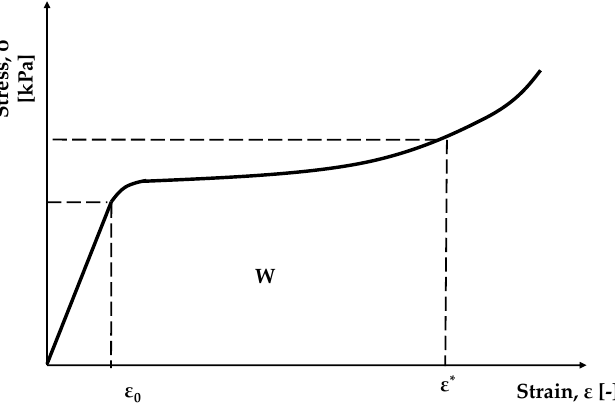
Figure 2. A stress–strain curve for a foam.